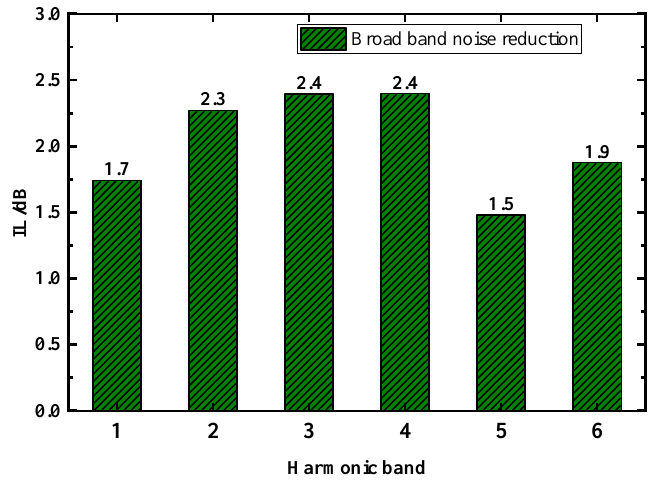
Figure 6. IL of CT at the first six harmonic bands.